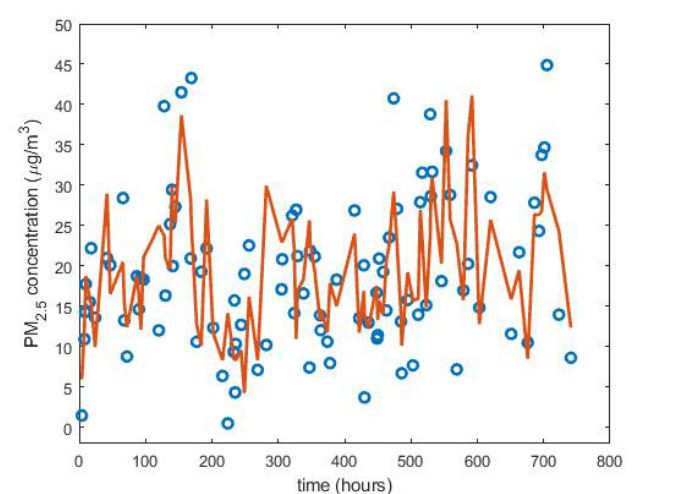
Figure 12. True points for the month of March 2019 (shown with blue circles) and the result of the piecewise interpolation method (shown by the curves in red). Here, 100 data were randomly removed from March 2019, and the piecewise linear interpolation method was the one that gave the best